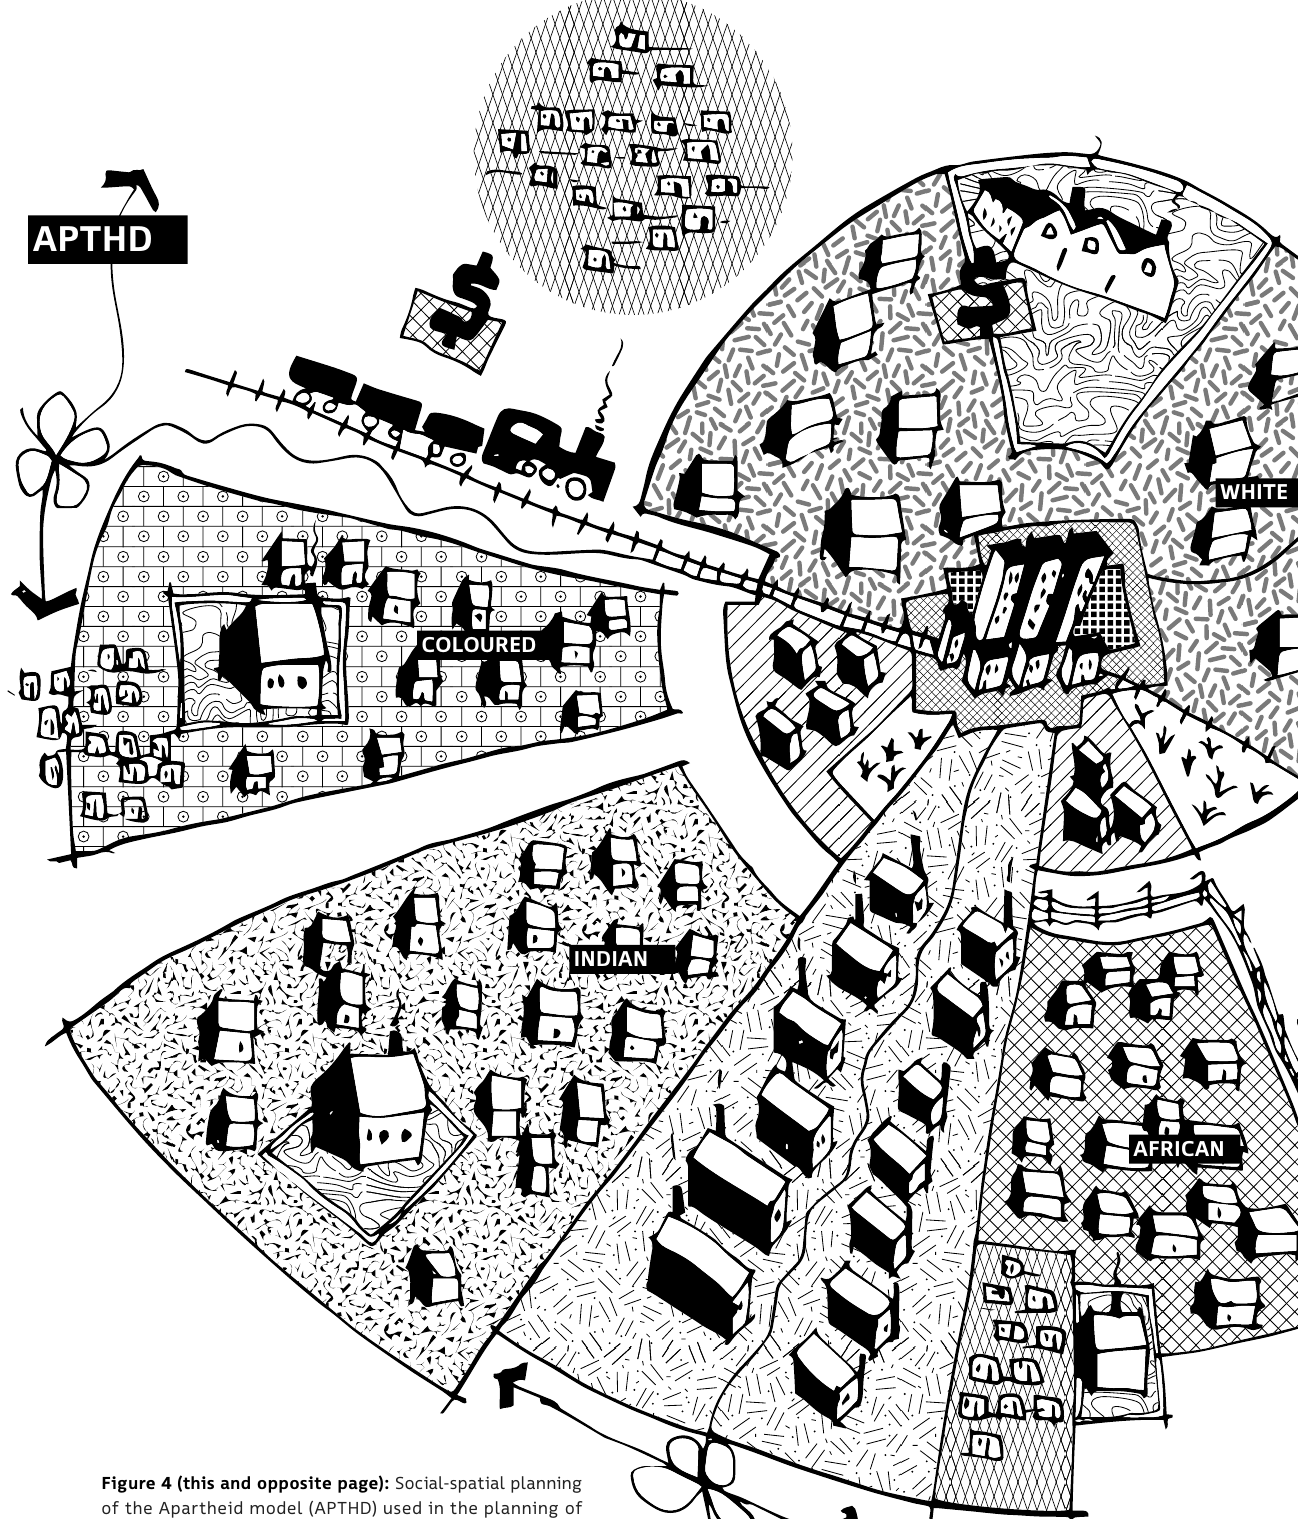
Figure 4 (this and opposite page): Social-spatial planning of the Apartheid model (APTHD) used in the planning of South African cities, drawn after Simon (1989). Mixed media drawing. Source: